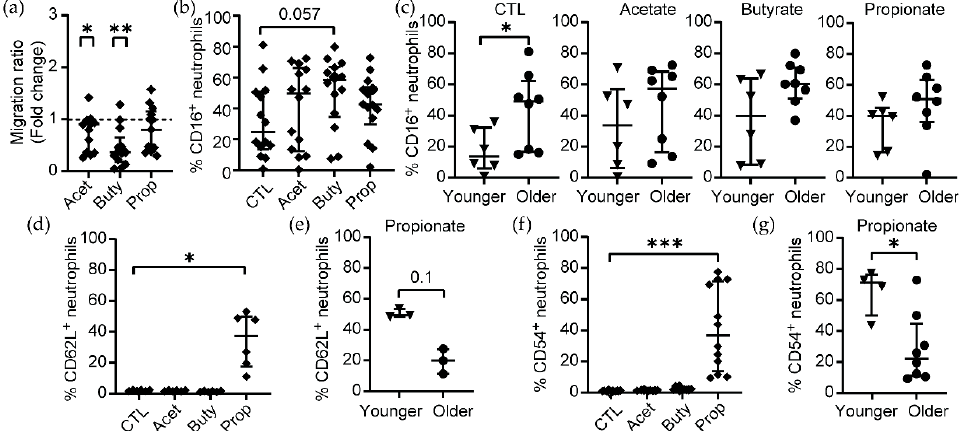
Figure 3. High concentrations of acetate and butyrate inhibit neutrophil migration. ( a ) Migration ratio of neutrophils in the presence of SCFAs 25 mM for 3 h ( n = 14). ( b ) Expression of CD16 on neutrophils that migrated to the bottom chamber after 3 h in the absence (control: CTL) or presence of different SCFAs (25 mM) measured by flow cytometry ( n = 14). ( c ) Effect of age on CD16 + neutrophils treated with SCFAs 25 mM (younger = 6; older = 8). Migrated neutrophils in the bottom chamber of the transwell were collected and the percentage of ( d ) CD62L + neutrophils in the absence or presence of SCFAs was quantified ( n = 6). ( e ) Effect of age on CD62L + neutrophils that migrated towards propionate (younger = 3; older = 3). The same analysis was conducted for CD54 + neutrophils ( f , n = 12), and effect of age on CD54 + neutrophils that were chemoattracted by propionate ( g ) was examined (younger = 4; older = 8). Each dot represents a different patient. ( a , c ) Wilcoxon t-test and ( b , d - g ) non-parametric paired Friedmann test were used; * p ≤ 0.05, ** p ≤ 0.01, *** p ≤ 0.001. CTL: control; Acet: acetate 25 mM; Buty: butyrate 25 mM; Prop: propionate 25 mM.